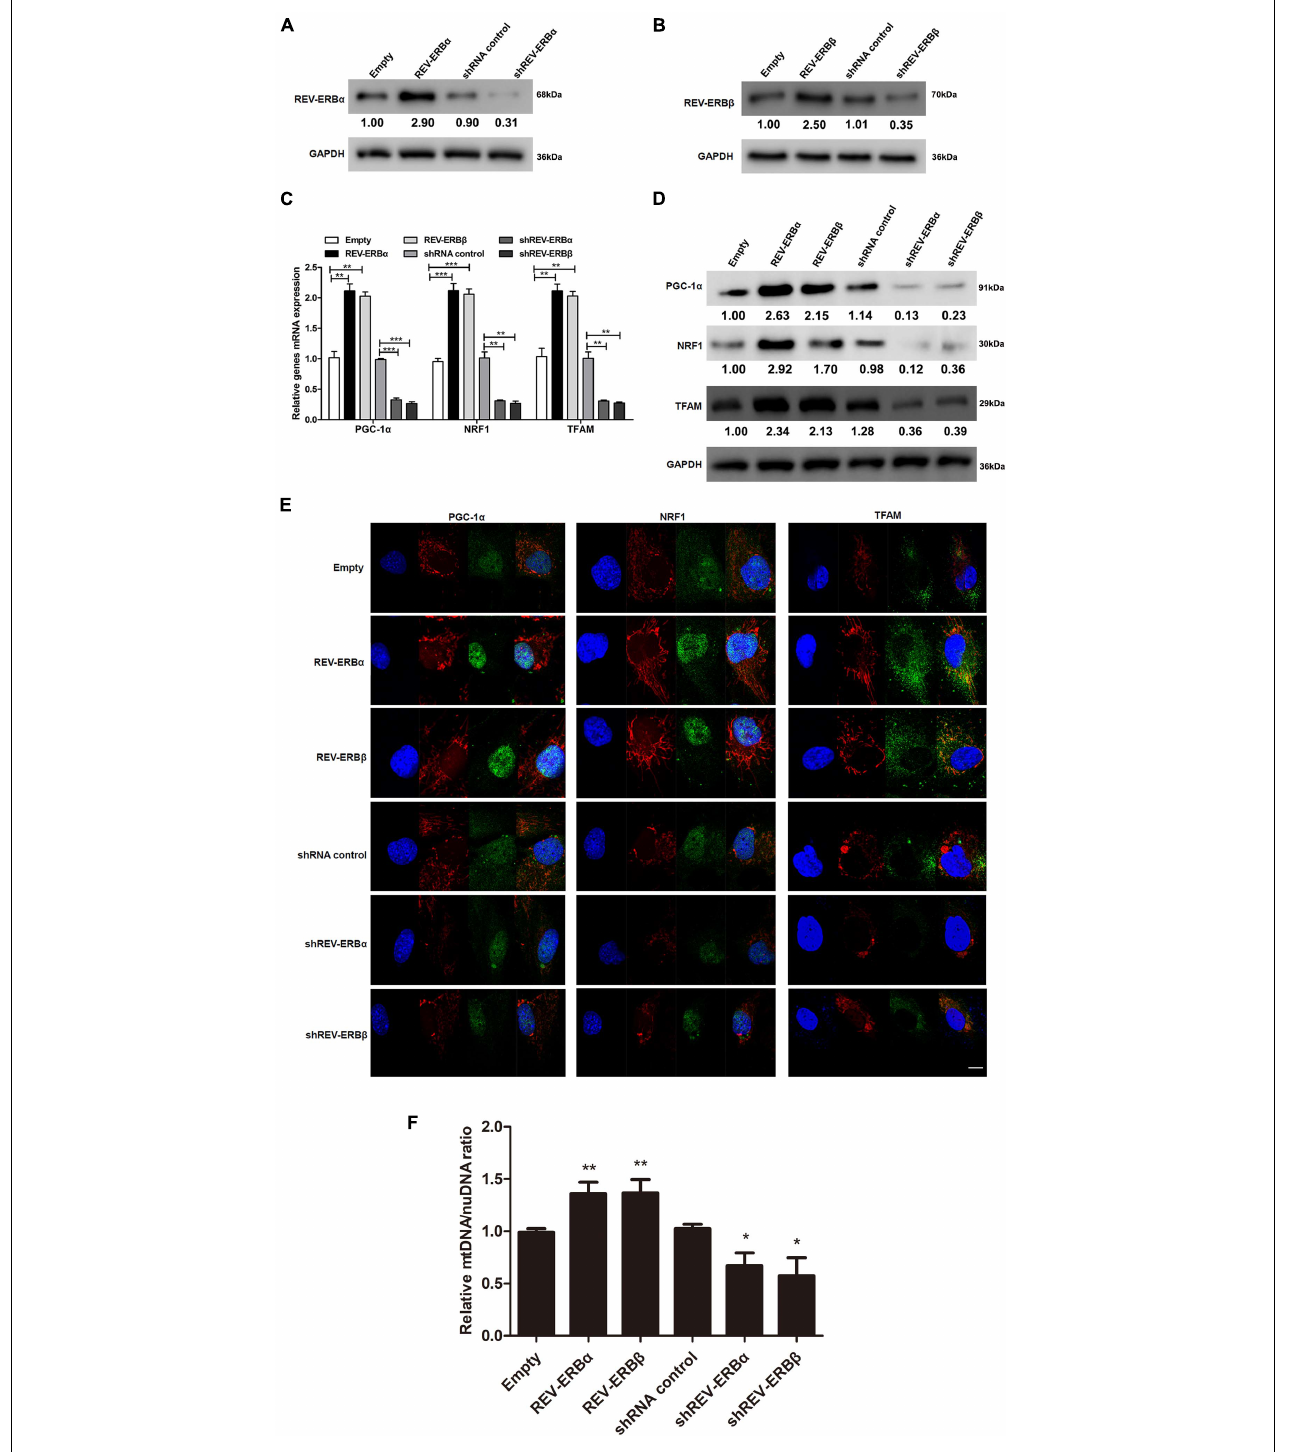
FIGURE 2 | Overexpression of REV-ERBs drives mitochondrial biogenesis in KGN cells. KGN cells transfected with empty vector, REV-ERB α , REV-ERB β , shRNA control, shREV-ERB α , or shREV-ERB β plasmid for 48 h. (A,B) Overexpression or silencing efficiency was analyzed by measuring REV-ERB α and REV-ERB β protein levels with western blotting. (C,D) Genes related to mitochondrial biogenesis levels in KGN cells were detected by qRT-PCR and western blotting. (E) Genes related to mitochondrial biogenesis in KGN cells were detected by immunofluorescence staining. Scale bars: 10 µ m. Blue fluorescence represents DAPI staining; Red fluorescence represents the location of mitochondria, which is stained by Mitotracker; Green fluorescence represents the targeted protein expression; Merged images are yellow. (F) Mitochondrial to nuclear DNA ratio. Data are presented as means ± SEM. * P < 0.05, ** P < 0.01, *** P < 0.001 vs. empty vector or shRNA